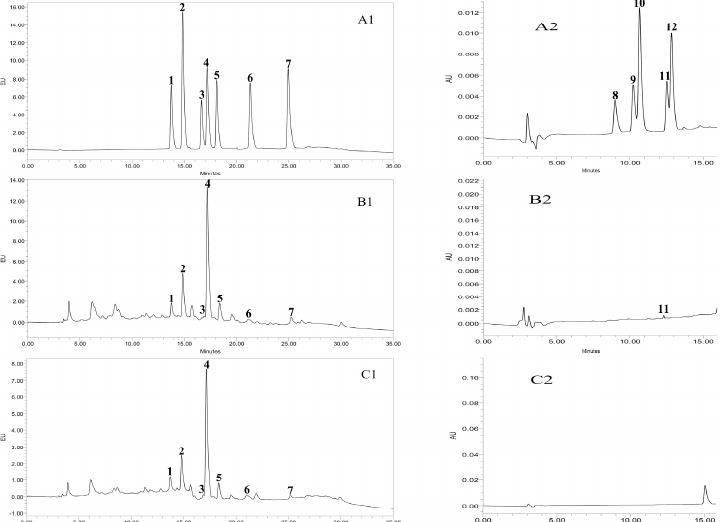
Figure 6. HPLC chromatograms of the HCA standard mix ( A1 ) for Non-IQ-type HCAs (10 ng/mL) by fluorescence detection and ( A2 ) for IQ-type HCAs (100 ng/mL) by UV detection; ( B1 , B2 ), HCAs in fried beef patties without the Rosa rugosa tea extract (control) at 220 °C detected by fluorescence and UV detection, respectively; ( C1 , C2 ), HCAs in fried patties with the Rosa rugosa tea extract at 220 °C detected by fluorescence and UV detection, respectively. Peaks: 1. Norharman, 2. Harman, 3. Trp-P-2, 4. PhIP, 5. Trp-P-1, 6. A α C, 7. MeA α C, 8. IQ, 9. MeIQ, 10. MeIQx, 11. 7,8-DiMeIQx, 12. 4,8-DiMeIQx.